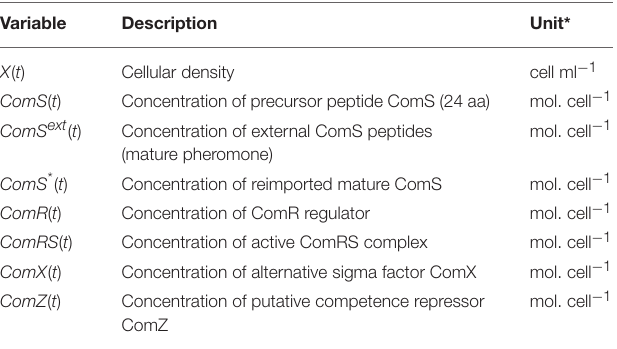
TABLE 1 | Description of variables in system